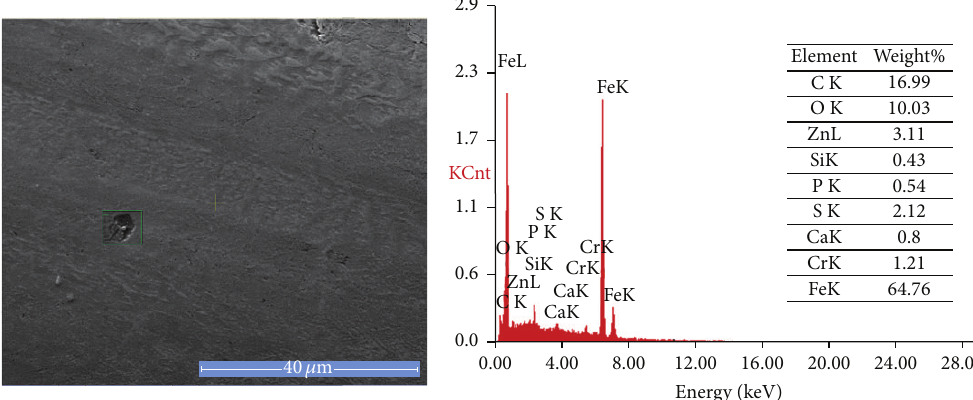
Figure 9: SEM image and elemental composition of surface of a ball which initially run on Oil A for 60 min and then on Oil A1 using same balls for 75